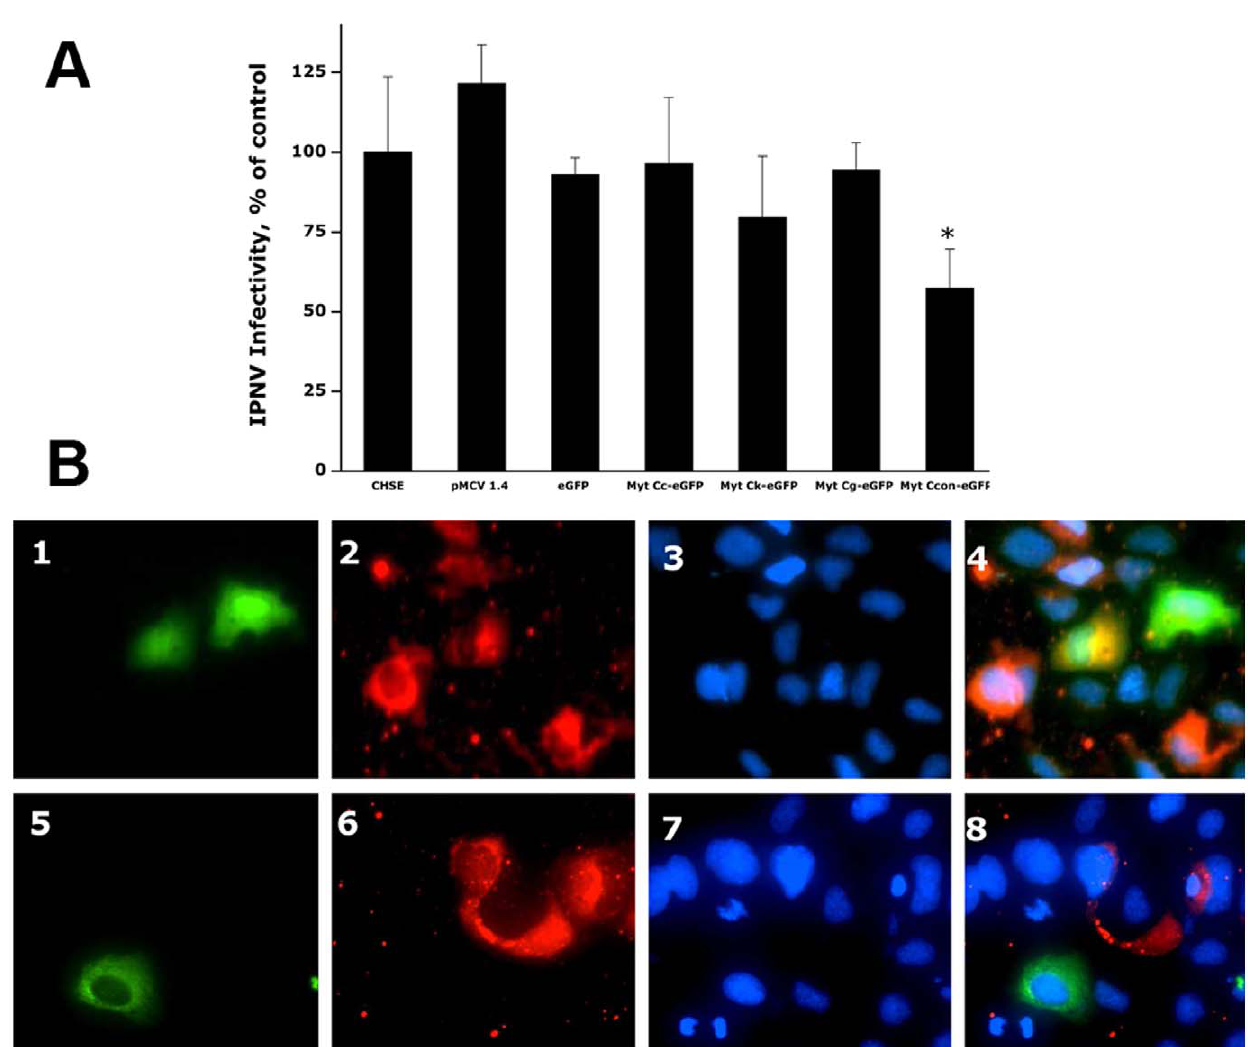
Figure 5. Resistance of CHSE cells expressing the Myt C variants to IPNV infection. CHSE cells were non-transfected or transfected with pMCV1.4, pMCV1.4-eGFP or with each of the pMCV1.4-Myt C-eGFP plasmids for 24 h, washed and then infected with VHSV for 2 h at 14 u C. After washing unbound virus, the infected cell monolayers were incubated for 24 h at 16 u C, and viral infectivity was estimated by RT-qPCR. A, expression levels of IPNV segment A in infected CHSE cells. The data are presented as the mean 6 S.D. from two independent experiments, each performed in triplicate. Asterisks indicate significant differences (p , 0.01) in viral infectivity relative to control cells (IPNV infected but non-transfected CHSE cells). B, IPNV replication in CHSE-Myt C expressing cells. CHSE cells were transfected with pMCV1.4-eGFP (upper panel) or pMCV1.4-Myt Cc-eGFP (lower panel) plasmids and infected with IPNV as above. Cell monolayers were then fixed and stained. 1 and 5 GFP fluorescence (green fluorescence); 2 and 6, stained with the MAb 2F12 anti-VP2 protein of IPNV and anti IgG-TRITC (red fluorescence); 3 and 7, stained with the Hoechst DNA stain (blue fluorescence); 4 and 8, merged images.